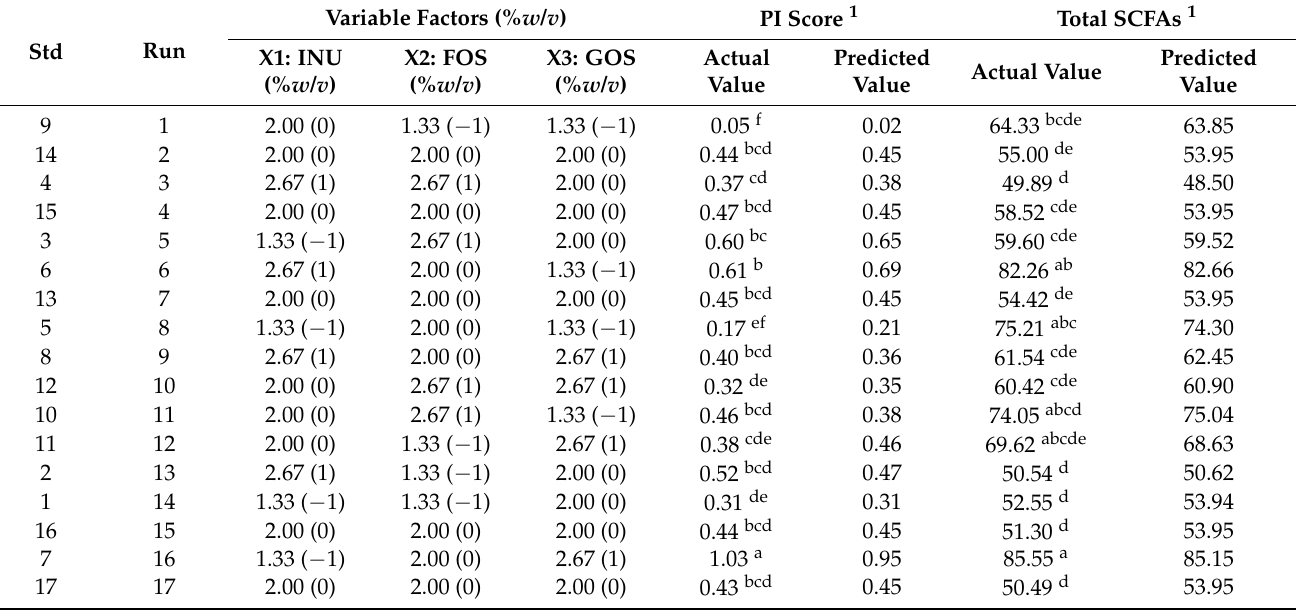
Table 2. The actual and predicted values of the PI score and total SCFAs for the mixed prebiotics following the run of a Box–Behnken design (BBD). Std Run